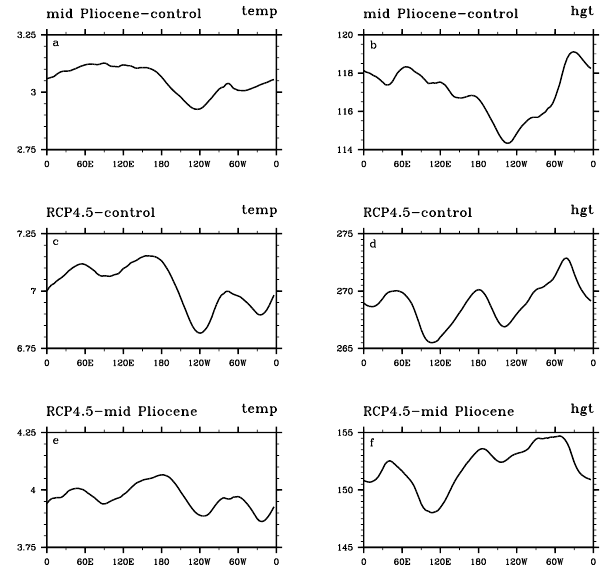
Fig. 7. Annual mean vertically averaged air temperature ( ◦ C) in the Fig. 7 Annual mean vertically averaged air temperature (ºC) in the upper troposphere 2 upper troposphere (400hPa to 100hPa) derived from (a) the control (400hPa to 100hPa) derived from (a) the control run, (b) mid Pliocene and (c) RCP4.5 3 run, (b) mid-Pliocene and (c) the RCP4.5 scenario. Potential height scenario. Potential height (units: 10 2 m) derived from (d) the control run, (e) mid 4 (units: 10 2 m) derived from (d) the control run, (e) mid-Pliocene Pliocene and (f) RCP4.5 scenario. 5 and (f) the RCP4.5 scenario.